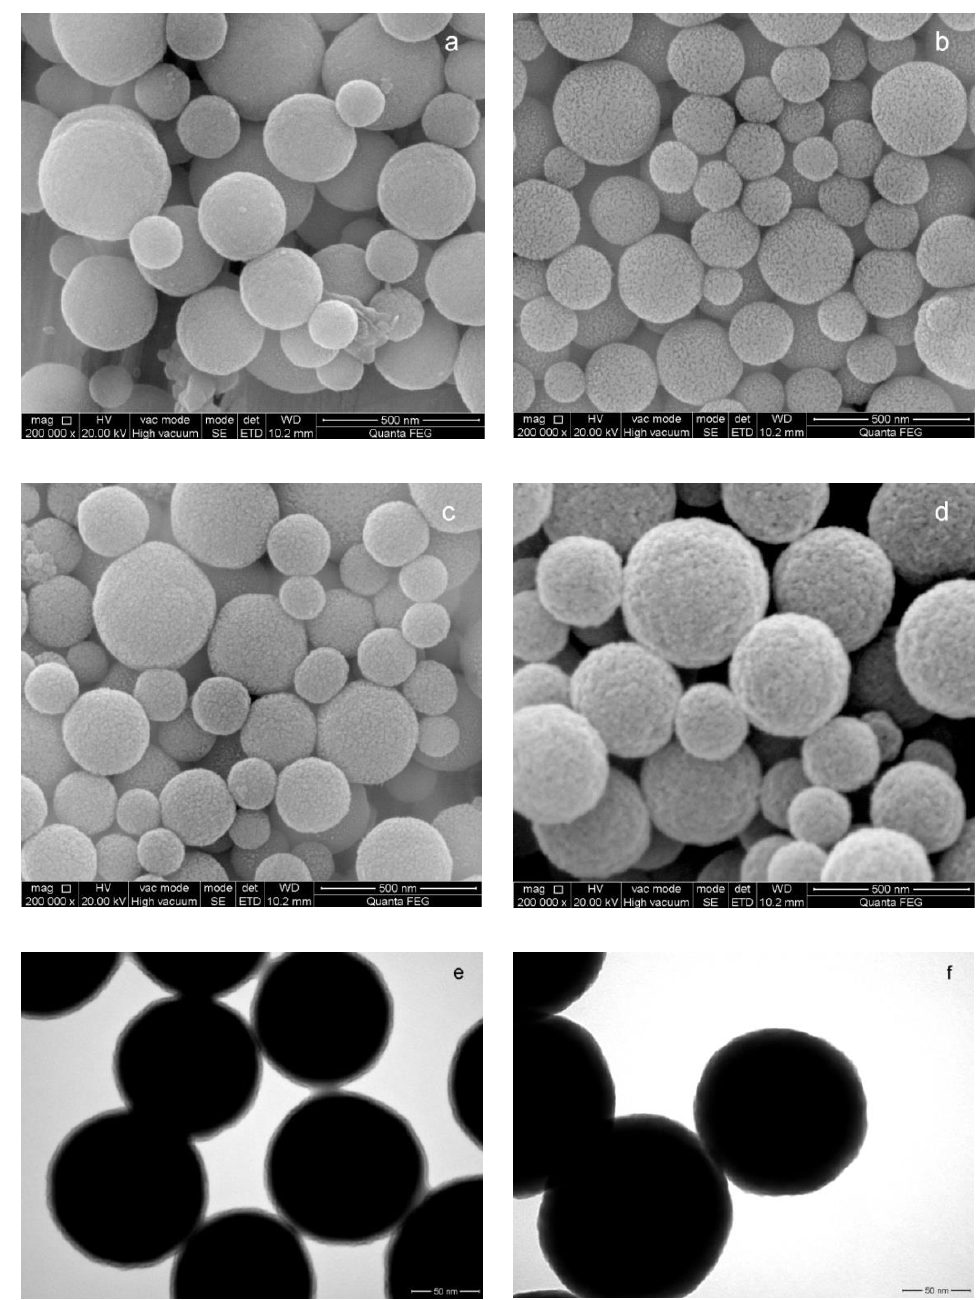
Figure 3. SEM and TEM images of ( a ) PVC, ( b ) PVC@TAA, ( c , e ) PVC@TAA-BSA, and ( d , f )